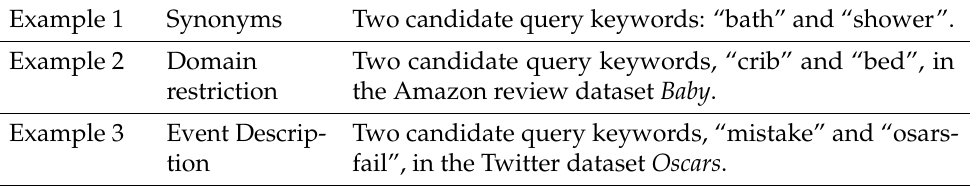
Table 1. Three examples where targeted aspect can be expressed by multiple different